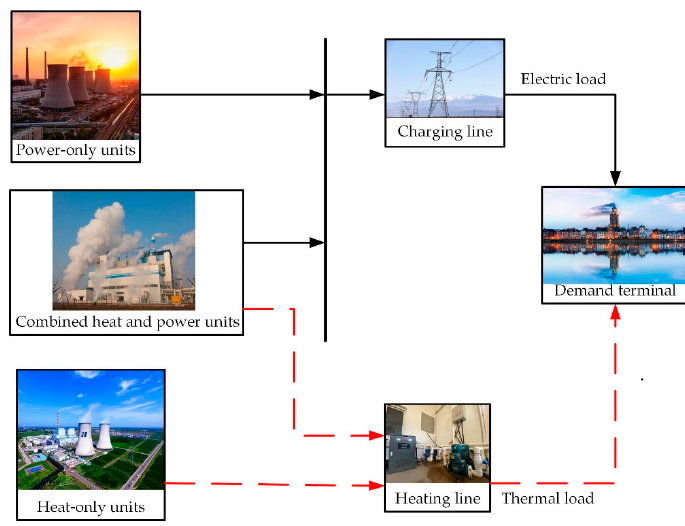
Figure 4. Cogeneration system.